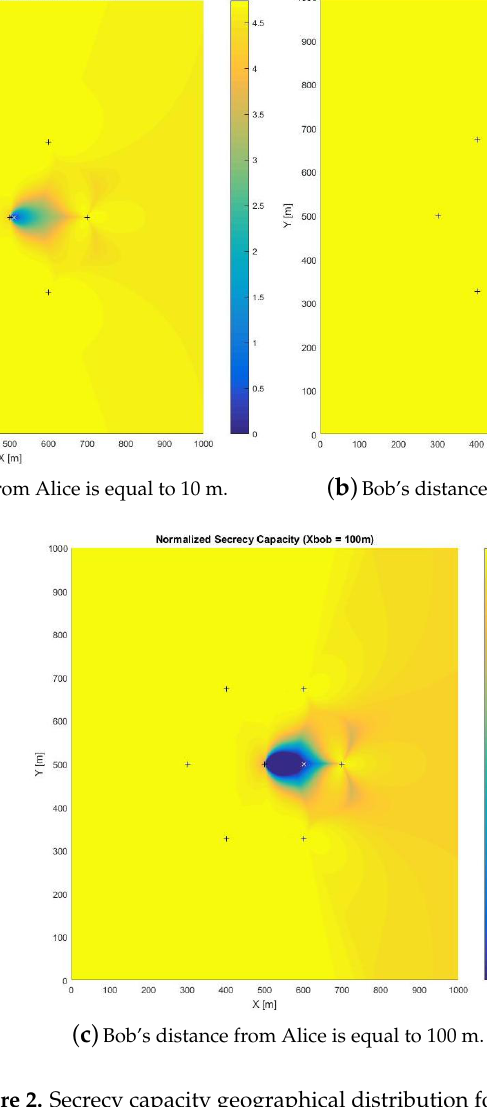
Figure 2. Secrecy capacity geographical distribution for P = 20 W.